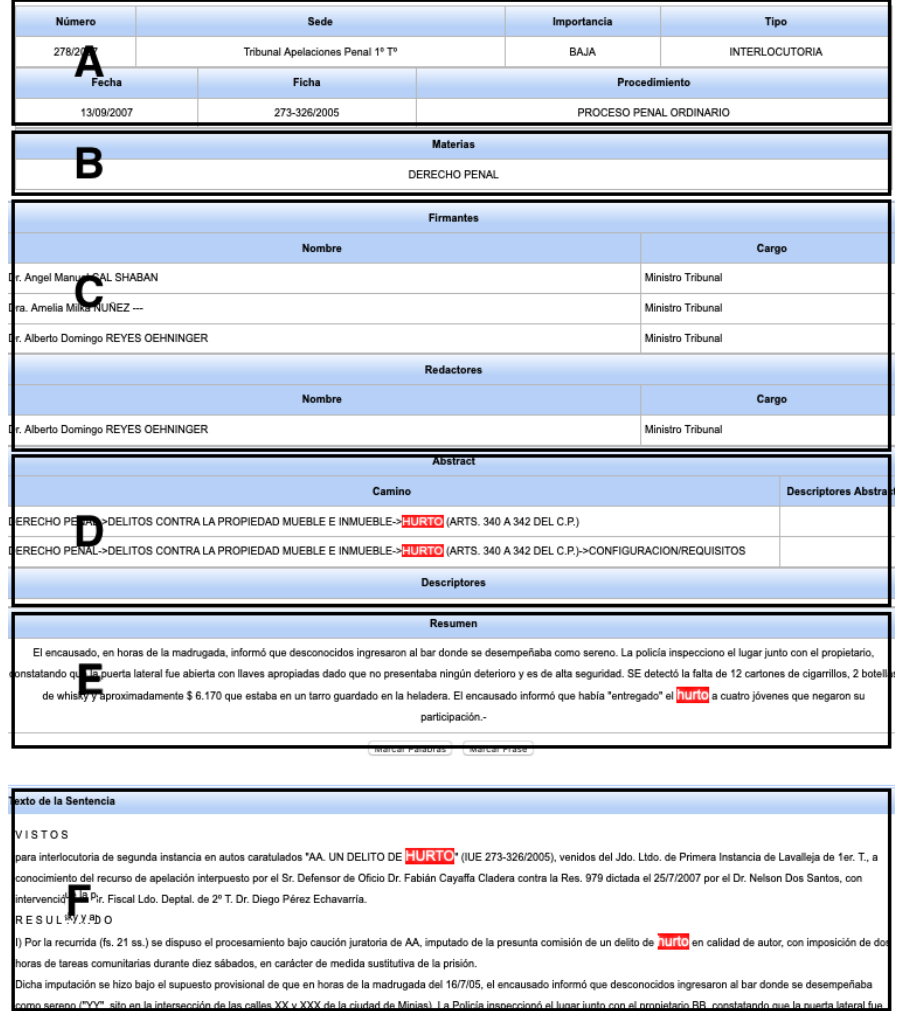
Figure 1. Example of a NJB decision. Published information includes: ( A ) general information of the decision: identification number, date, type of decision, etc.; ( B ) theme; ( C ) jury; ( D ) classification; ( E ) summary; and ( F ) text of the